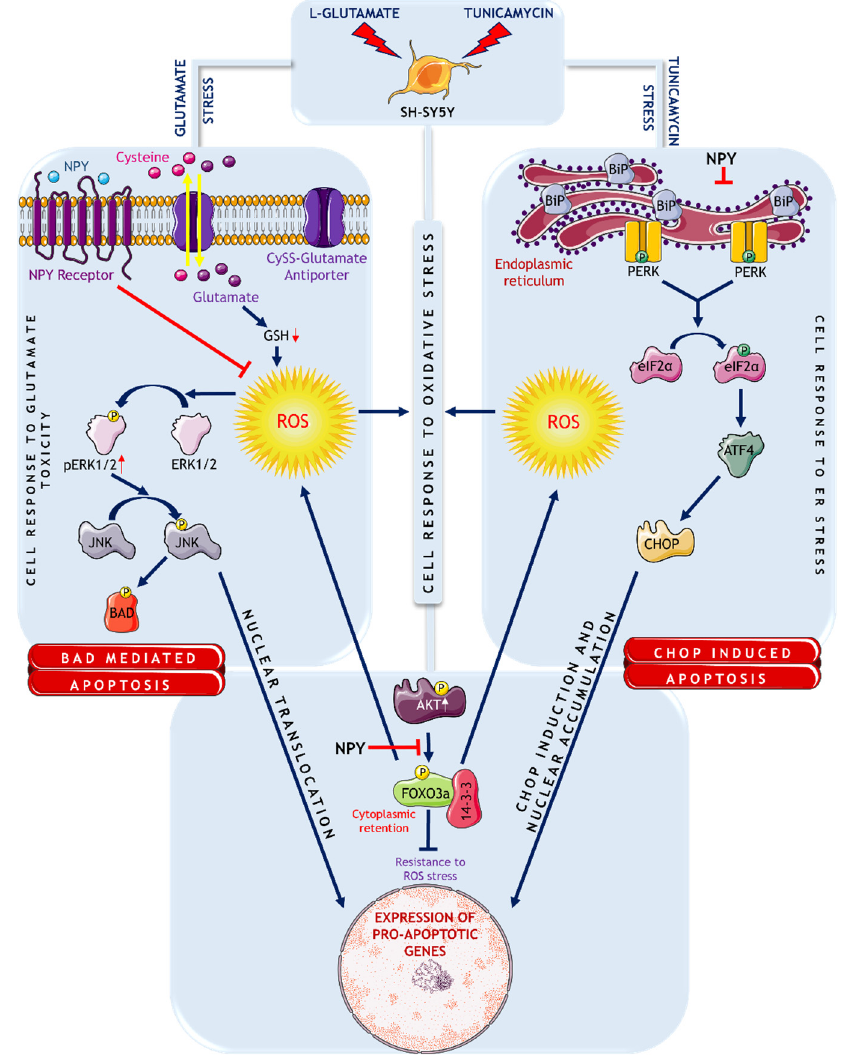
Figure 8. Schematic representation of signalling mechanisms involved in glutamate excitotoxicity and ER stress on SH-SY5Y cells. Source: This figure was created using Servier Medical Art